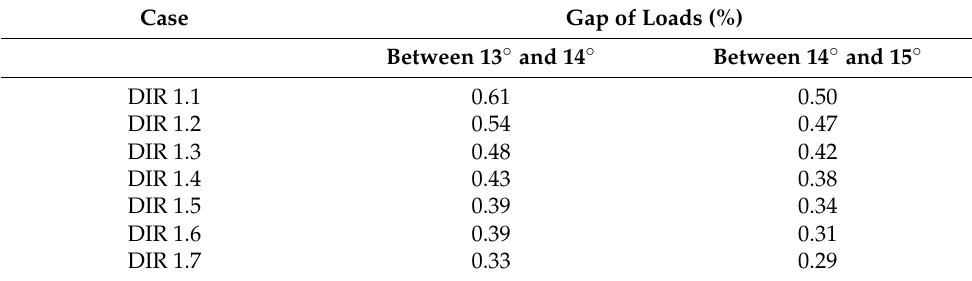
Figure 7. Combined redrawing-ironing load according to the die angle (1 – 15°) at each DIR (1.1). Table 1. Gaps of the combined redrawing-ironing loads by varying DIR. Case Gap of Loads (%) Between 13 ° and 14 ° Between 14 ° and 15 ° DIR 1.1